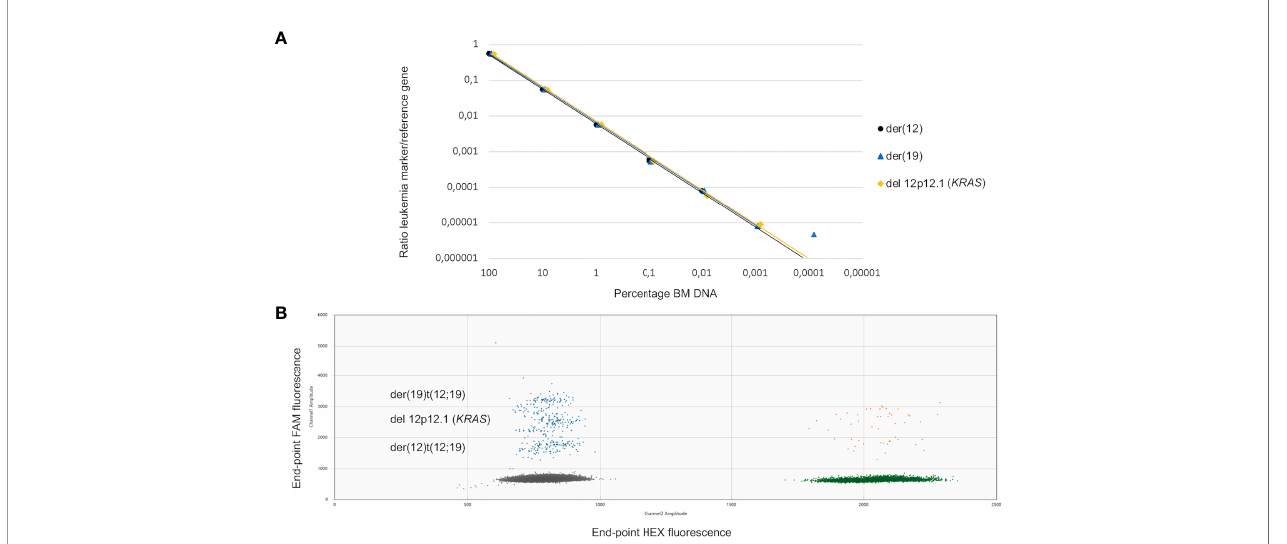
FIGURE 3 | (A, B) Dilution series and ddPCR fl uorescence plot for leukemic targets in patient 1. (A) Sensitivity testing for the three targets selected for patient 1, der (12), der(19) and deletion 12p. The ratios of CN target to CN reference obtained from the ddPCR assays are plotted against the percentage of gDNA from the diagnostic BM for the different dilutions using 500 ng of input gDNA. (B) 2D fl uorescence amplitude plot generated by the QuantaSoft ™ software showing the droplet clusters corresponding to the three different targets for patient 1 (der(12), der(19), and deletion 12p using 1 ng of PC in a background of 9 ng of NC. y-Axis, end-point FAM- fl uorescence from targets. x-Axis, end-point HEX- fl uorescence from reference gene. Negative droplets (gray). Target positive – reference negative droplets (blue). Reference positive – target negative droplets (green). Double-positive droplets (orange). ddPCR, droplet digital PCR; CN, copy number; gDNA, genomic DNA; BM, bone marrow; PC, positive control; NC, negative control.